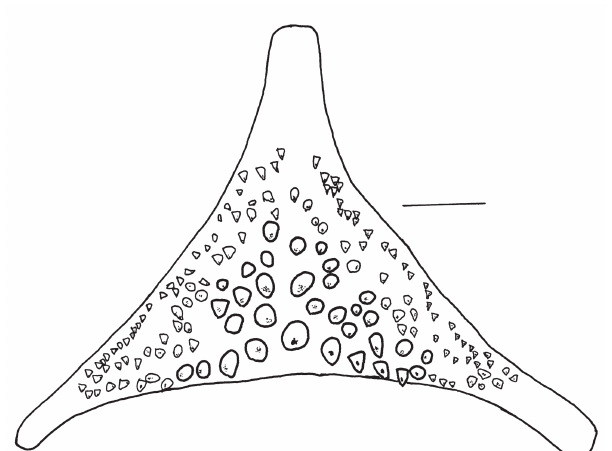
Fig. 8 . Crenicichla empheres , lower pharyngeal tooth plate in occlusal view, MCP 40176 (93.2 mm SL, female). Scale bar: